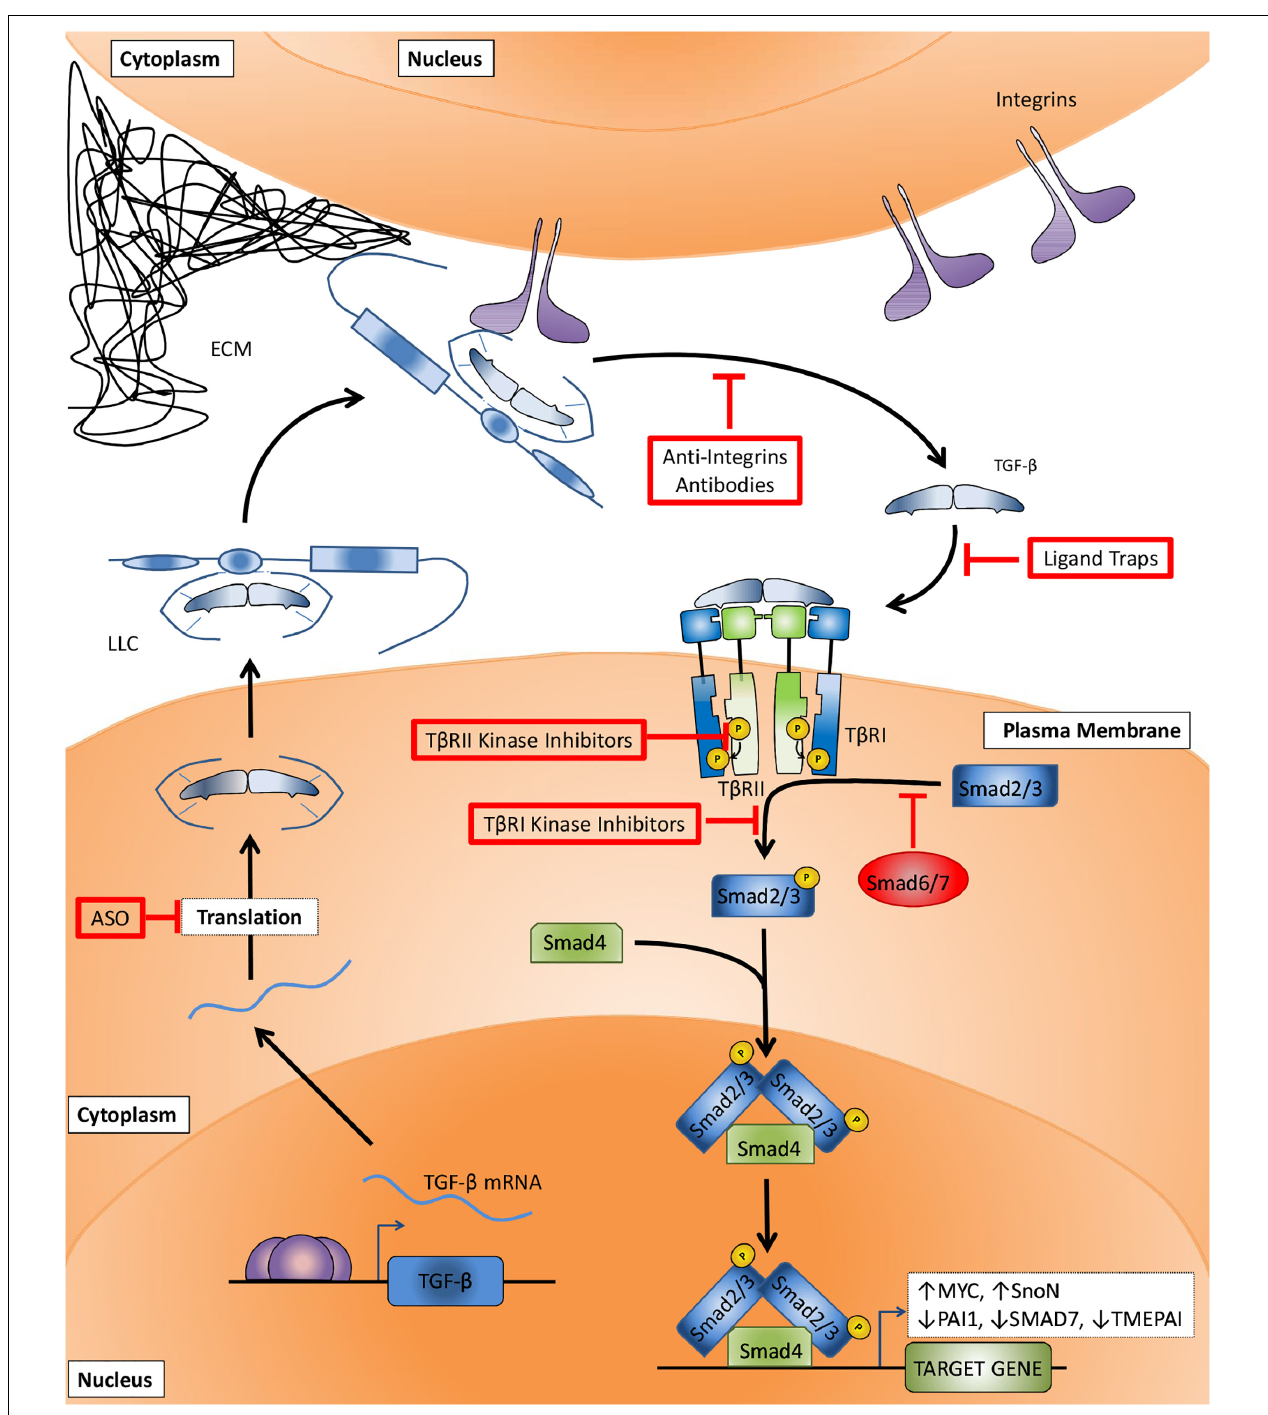
FIGURE 2 | Canonical TGF- β signaling pathway and TGF- β signaling targeting therapies. After TGF- β mRNA translation (step I) and secretion, the large latent complex (LLC) composed of TGF- β , latency associated peptide (LAP), and latent TGF- β binding protein (LTBP) is deposited to the extracellular matrix (ECM). The interaction between LTBP and integrins increases TGF- β :LAP dissociation and TGF- β activation (step II). TGF- β binding to surface receptors (step III) is followed by T β RII-mediated T β RI transphosphorylation (step IV). The signaling is then transduced to cytosol by T β RI-induced phosphorylation of SMAD2 and 3 (step V), followed by their association with SMAD4, accumulation in the nucleus and regulation of target genes transcription. Anti-TGF- β therapies target critical steps in order to impair TGF- β signaling. Antisense oligonucleotides (ASOs) prevent the translation of TGF- β mRNA (step I). Anti-integrins prevent TGF- β activation (step II). Ligand traps avoid cytokine binding to its receptors (step III). T β RII and T β RI kinase inhibitors block type II-mediated type I receptor phosphorylation (step IV) and type I-mediated SMAD2 and 3 phosphorylation (step V), respectively.